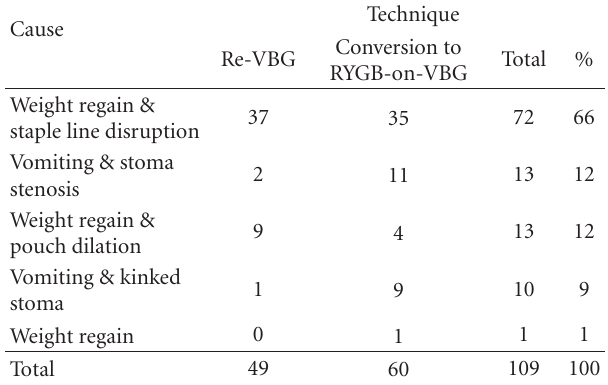
Table 2: Revisionary surgery for failed or complicated VBGs: causes of